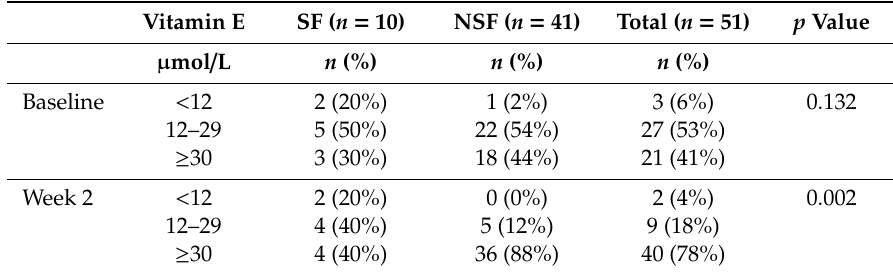
Table 4. Plasma vitamin E status of stone formers and non-stone formers at baseline and after ADEK